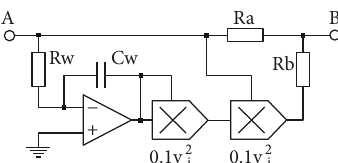
Figure 1: The alternative circuit of